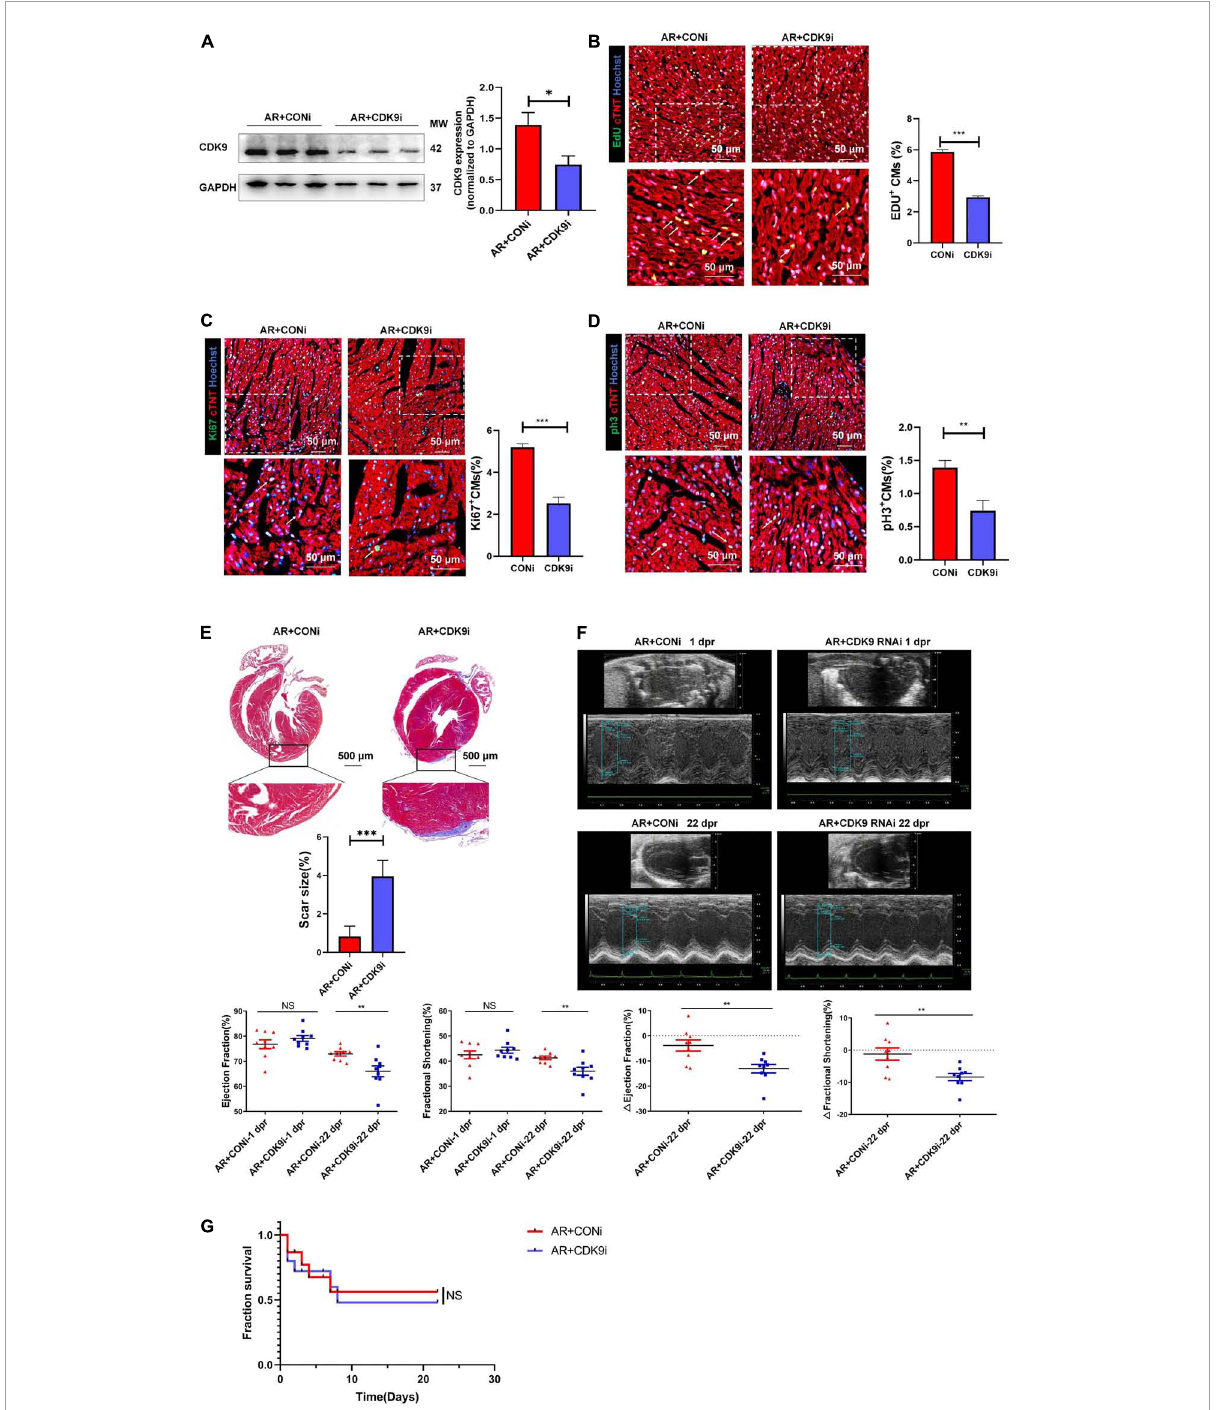
FIGURE4 CDK9 knockdown impairs myocardial regeneration after AR in neonatal mice. (A) CDK9 protein of ventricular myocardium in neonatal mice injected Ad5: cTnT-CON RNAi or Ad5: cTnT-CDK9 RNAi (CDK9i) after AR surgery detected by western blot at 6 days after surgery. (B–D) CM proliferation in neonatal myocardial tissue after intra-myocardial injection with CDK9i or CONi quantified by immunofluorescence for DNA synthesis (B) , cell-cycle activity (C) , mitosis (D) ( n = 3). (E) Comparison of scar size by Masson staining between the CONi and CDK9i groups at 22 days after AR surgery ( n = 6). (F) LVEF and LVFS in P1 AR mice at 1 and 22 days after CDK9i or CONi injection was detected by echocardiography ( n = 8). (G) Overall survival rate in neonatal mice from AR + CONi and AR + CDK9i groups ( n = 15). Scale bars, 500 µ m; CM indicates cardiomyocyte, MW indicates molecular weight; statistical significance was calculated with the unpaired Student t -test; data are presented as mean ± SEM, * P ≤ 0.05, ** P ≤ 0.01, *** P ≤ 0.001; each dot indicates a biological